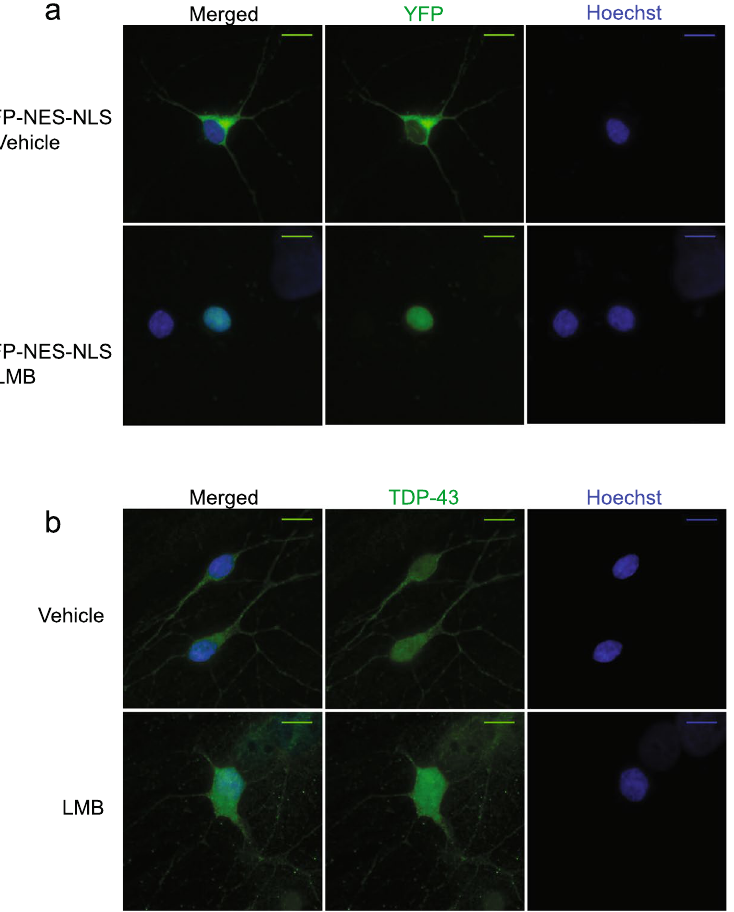
representative of three independent experiments. Scale bar- 10